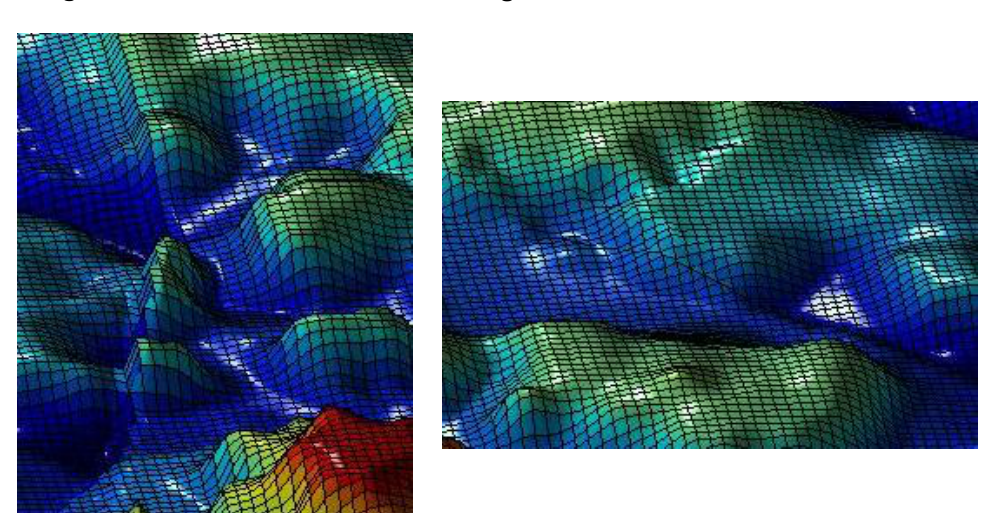
Figure 2. Animated topography via linear ―flip-page‖ transition showing artificial morphologic entities: cliff ( left ) and ravine ( right